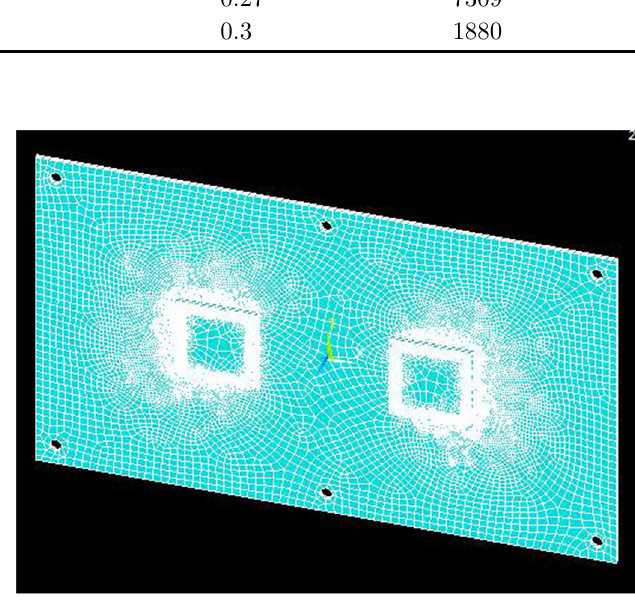
Fig. 7. Finite element model after